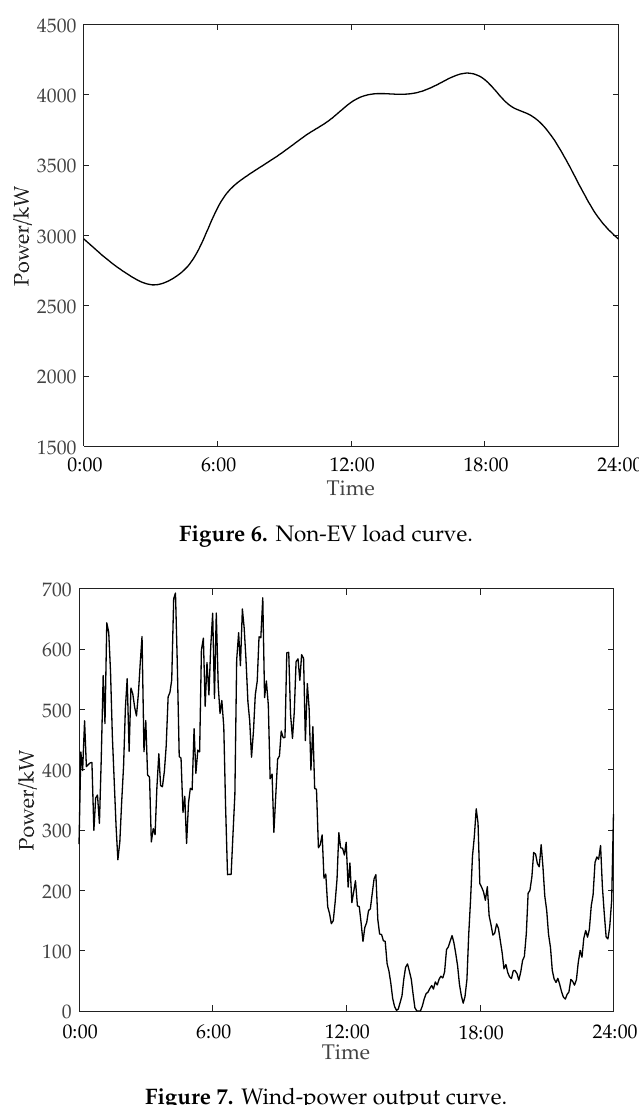
Figure 7. Wind-power output curve.